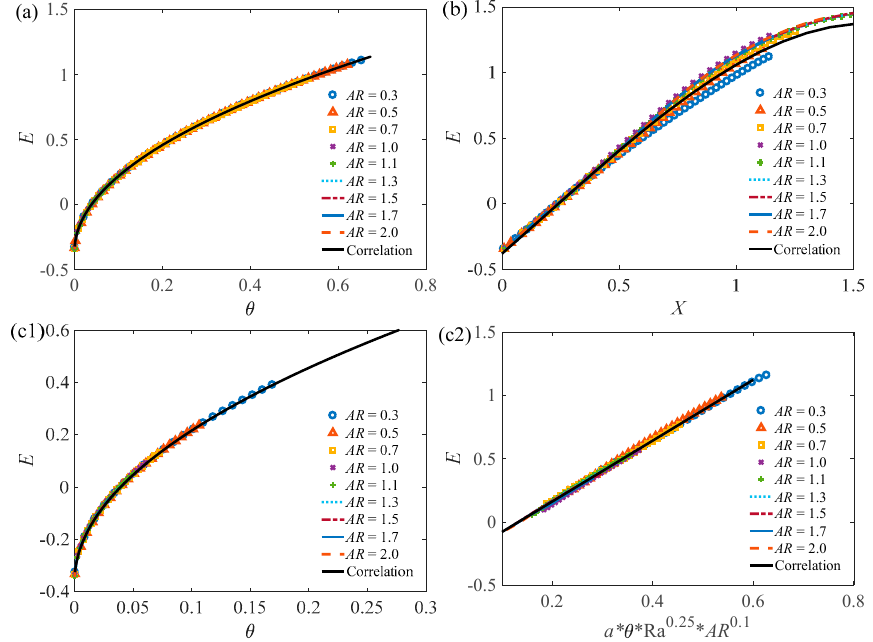
Figure 16. Unified results for dimensionless enthalpy of PCM in rectangular enclosures with di ff erent aspect ratios. ( a ) Heating the top side; ( b ) heating the right side; ( c1 ) heating the bottom side ( θ ≤ θ c ); ( c2 ) heating the bottom side ( θ > θ c ).